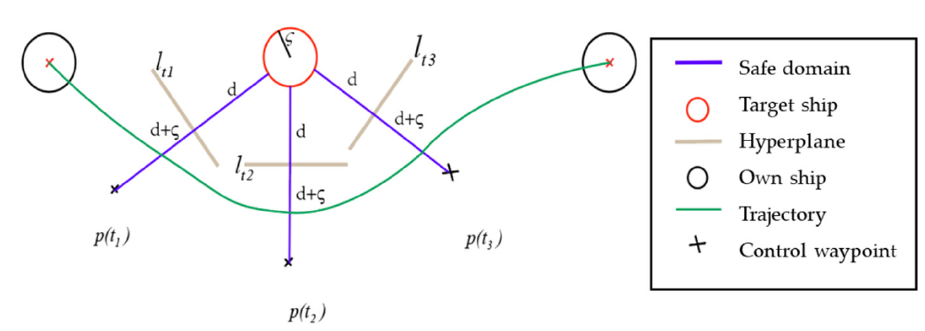
Figure 7. Collision avoidance trajectory planning and waypoint control.